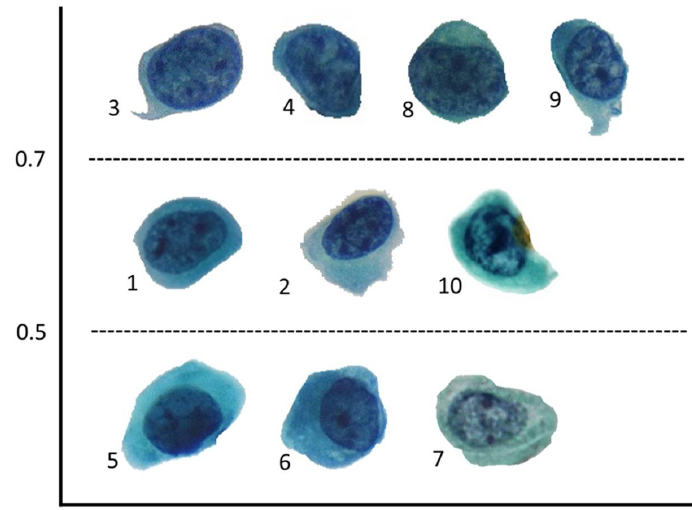
Figure 2. N / C ratio ranges of the representative urothelial cells in the online urine cytology survey. The small numbers over the lower left side near the cells indicate the question number in the online survey.